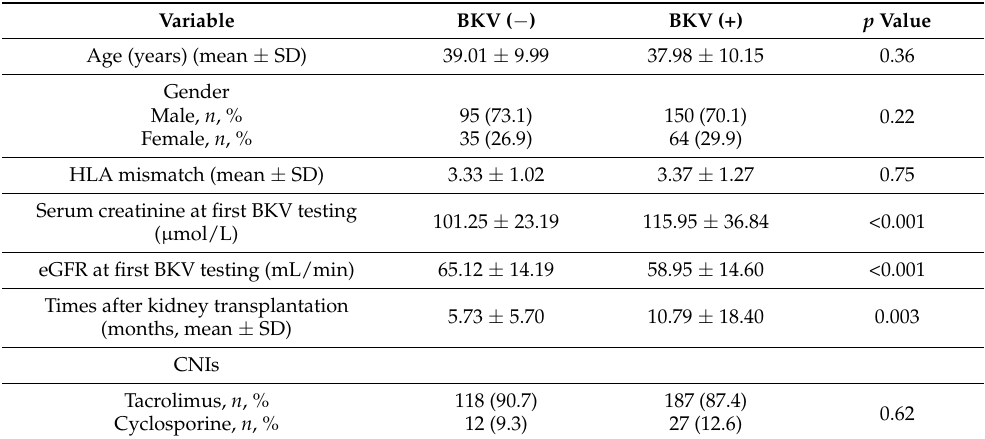
Table 4. Comparison between BKV and non-BKV groups.